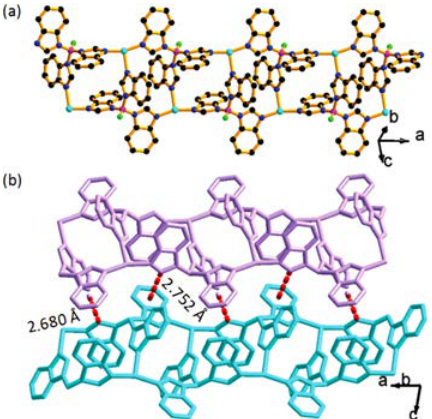
Figure 6. ( a ) View of the ladder-like chain in BIF-40; and ( b ) the packing view between chains in BIF-40, showing the C–H ··· π interactions (red dashedline) between the adjacent chains. Color codes: Cu, pale blue; B, purple; C, black; N, blue; H, green. Partial H atoms are omitted for clarity. Reprinted with permission from Reference 43.